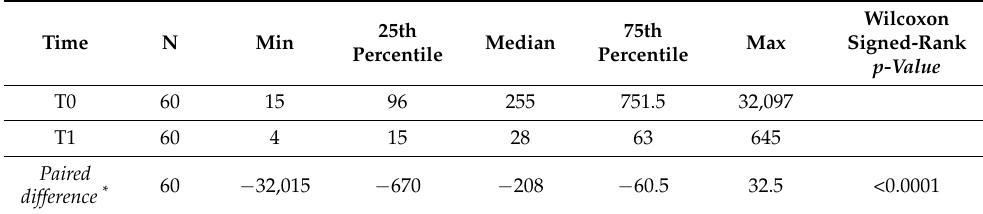
Table 1. Distributions of the Relative Light Unit (RLU) values for all tested surfaces. A cut-off of 150 RLU was set to consider a surface clean.